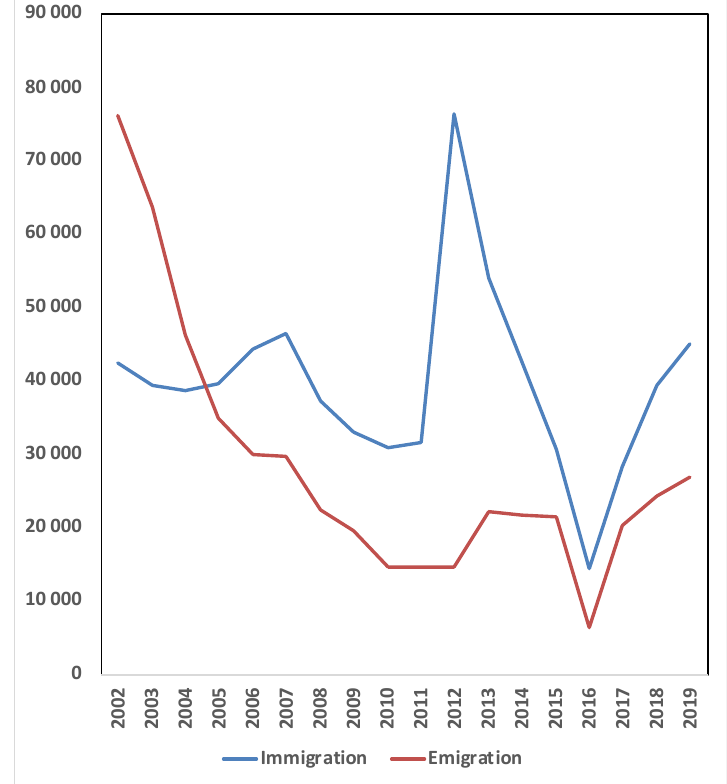
Figure 1. Immigration and emigration based on registration of residence, Ukraine 2002–2019